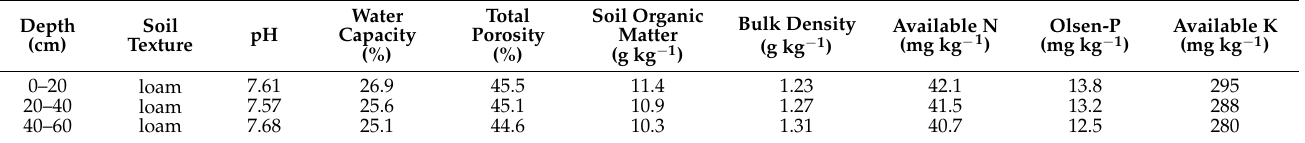
Table 1. Physical and chemical properties of soil before